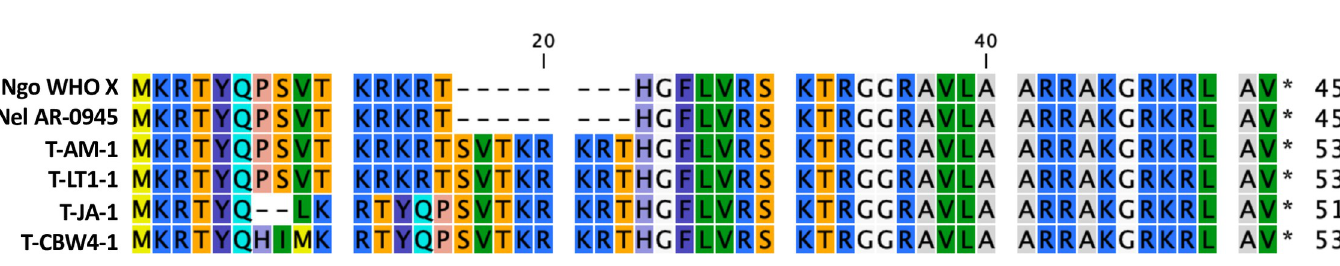
Fig 3. At both the nucleotide and amino acid level Nel AR-0945 RpmH is identical to the Ngo WHO F reference (LT591897.1) sequence. Evolved in-frame sequence duplications in Nel lineages introduce 8SVTKRKRT15, 7LKRTYQ12, and 8HIMKRTYQ15 insertions, which are identical to (7LKRTYQ12) and nearly identical to those recently discovered to confer high-level macrolide resistance in Ngo [32].